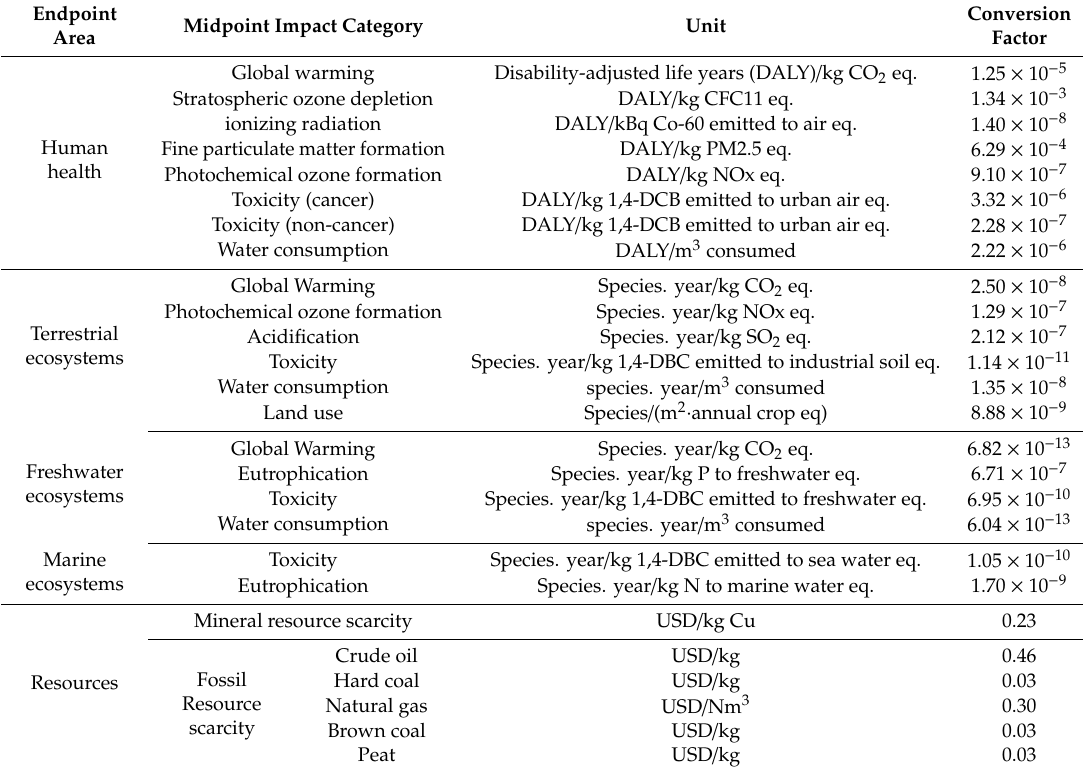
Table 4. Midpoint to endpoint conversion factors referring to ReCiPe2016